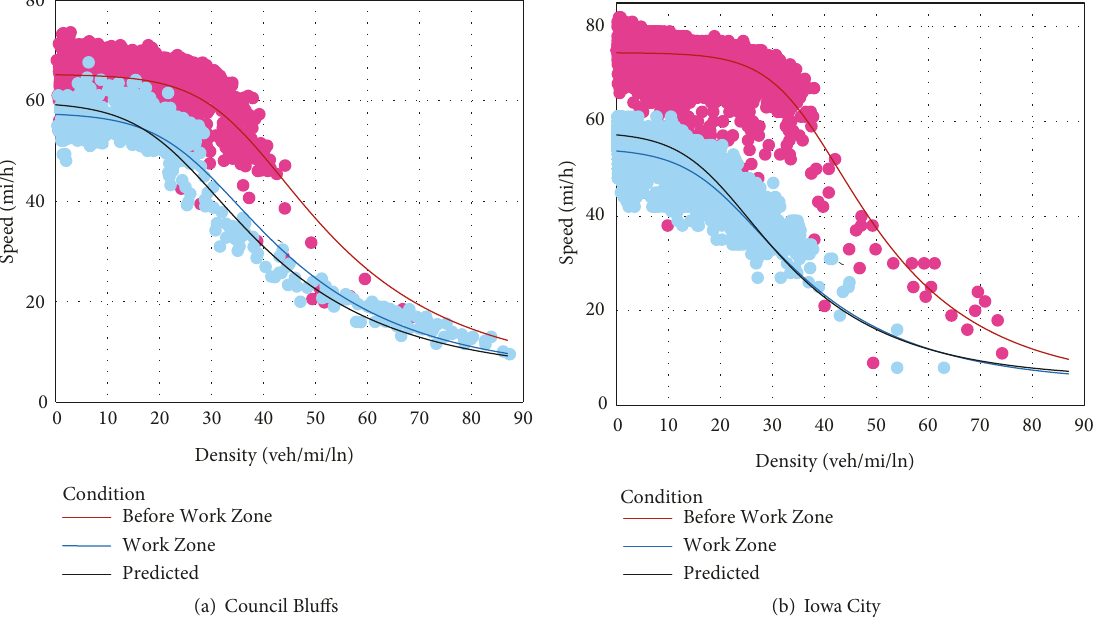
Figure 5: Speed-density relationships before and during work